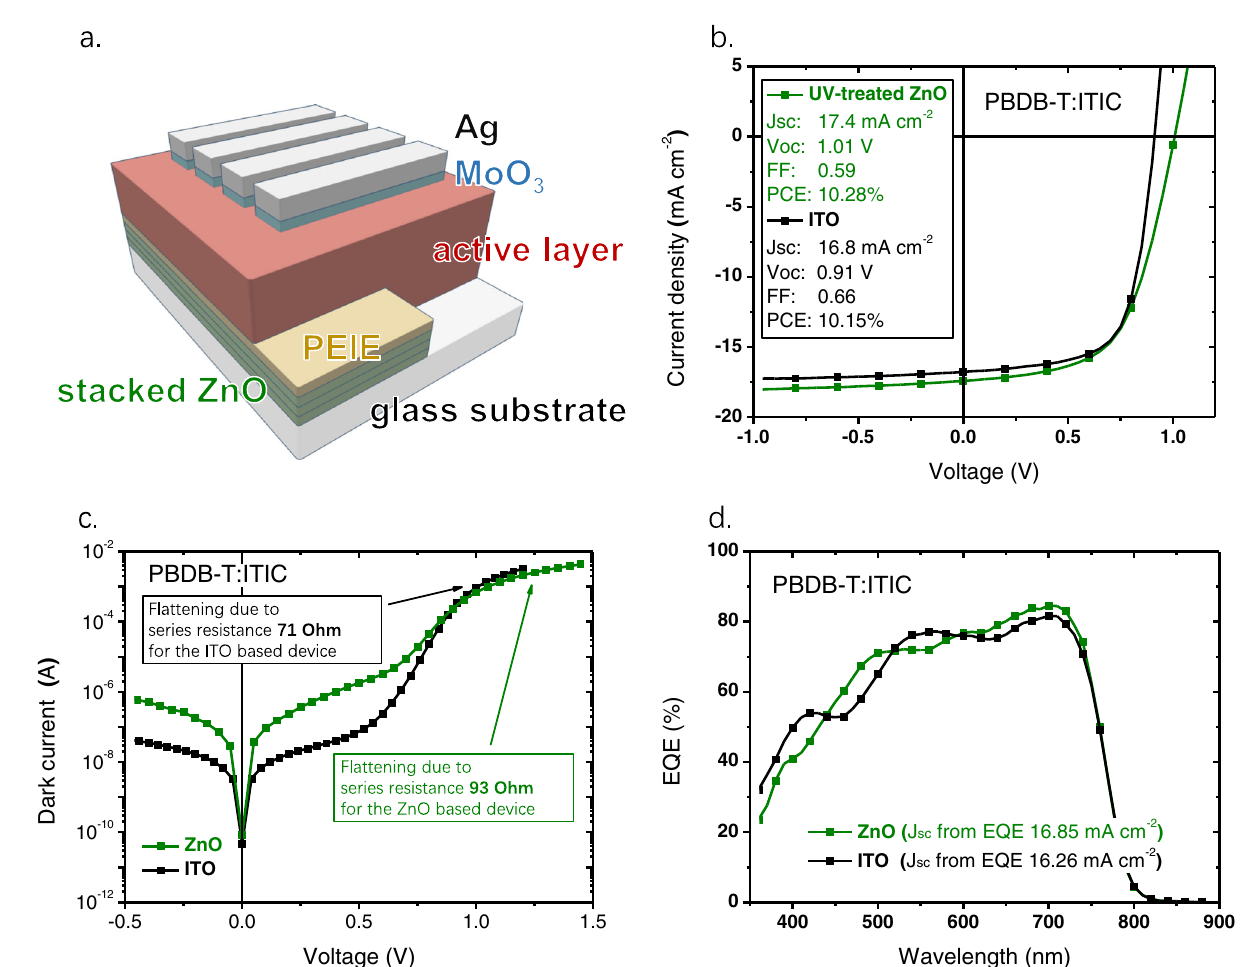
Fig. 6 | ITO-free solar cells based on the ZnO stack. a Schematic device archi- tecture for the ITO-free solar cells based on the ZnO stack acting as the cathode. b Light J-V curves, c dark current-voltage curves, and d EQE spectra of the PBDB- T:ITIC solar cells basedon ITOand theZnO stackwith 6 layersof ZnO,annealedat